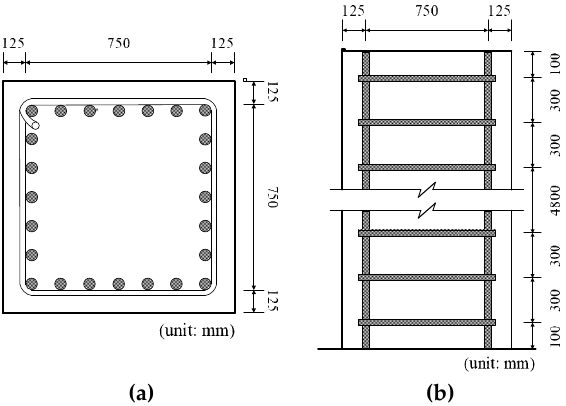
Figure 7. Dimensions of RC column: ( a ) cross-sectional dimension and ( b ) longitudinal dimension.